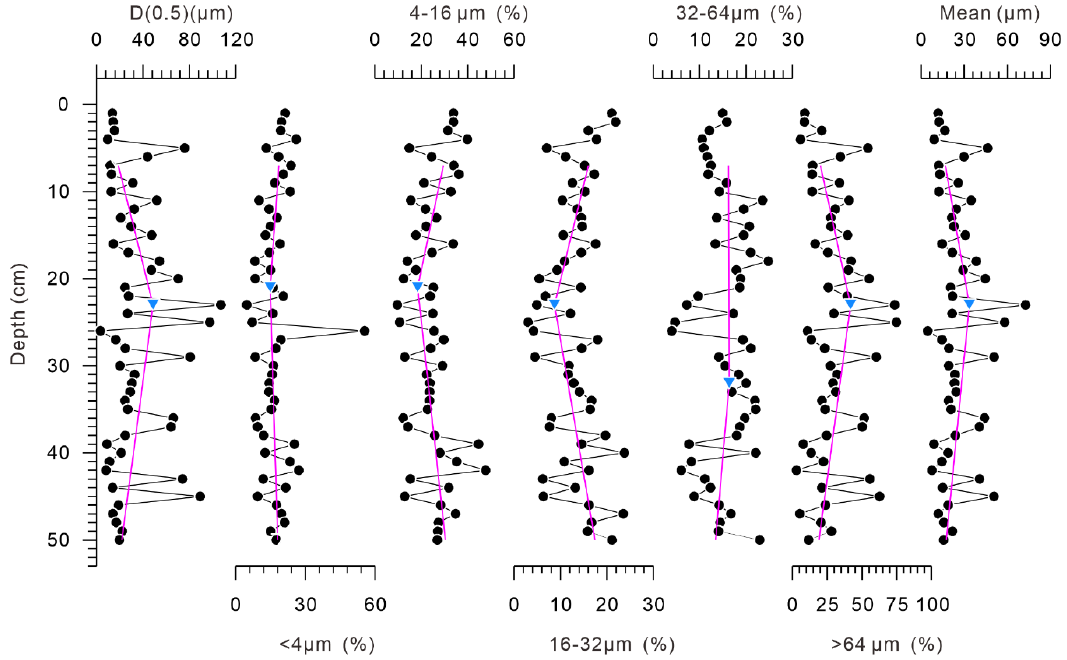
Figure 5. Grain size distribution and nonlinear trend fitting in sediment core TLC01 from Lake Ta-Lung-Chi. The blue triangles for the change points with the method of Piecewise linear fitting and trend changing points [51,52].